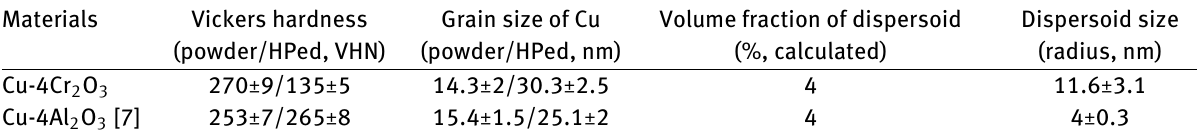
Table 2: Vickers hardness, grain sizes of Cu, vol.% of dispersoids, and dispersoid size for the Cu-4Cr 2 O 3 /4Al 2 O 3